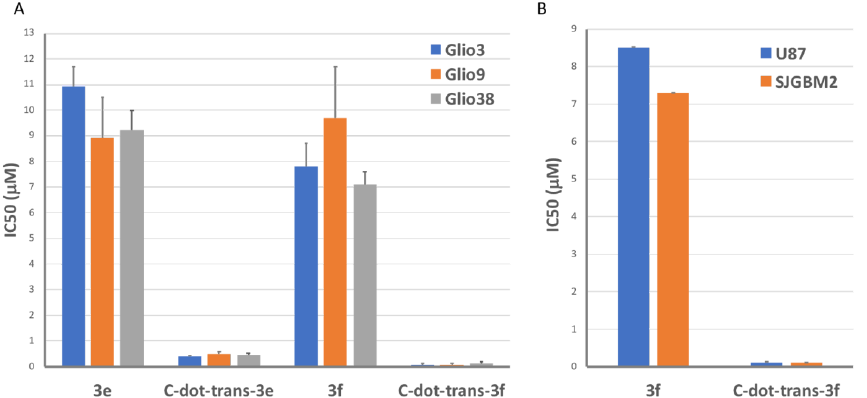
Figure 9. C-dot-trans conjugates up to 100-fold more effective than free drugs. ( A ) IC 50 of chalcones and C-dot-trans-chalcone conjugates in GSC lines Glio3, Glio9 and Glio38. ( B ) IC 50 of chalcone 3f and C-dot-trans- 3f in GBM non-stem cell lines, U87 (adult) and SJ-GBM2 (pediatric).